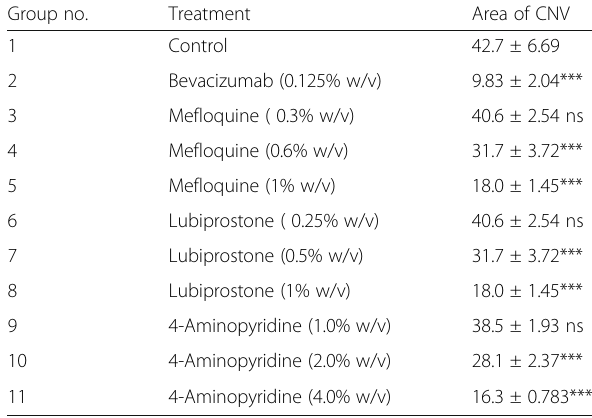
Table 2 Effect of ion channel modulators on the area of neovascularization in corneal neovascularization (CNV) method. Results were presented as mean ± SEM. The differences between the groups were compared by one-way ANOVA followed by post hoc Dunnett ’ s test. In all the groups, n = 6. *** p < 0.001, ** p < 0.01, * p < Group no.